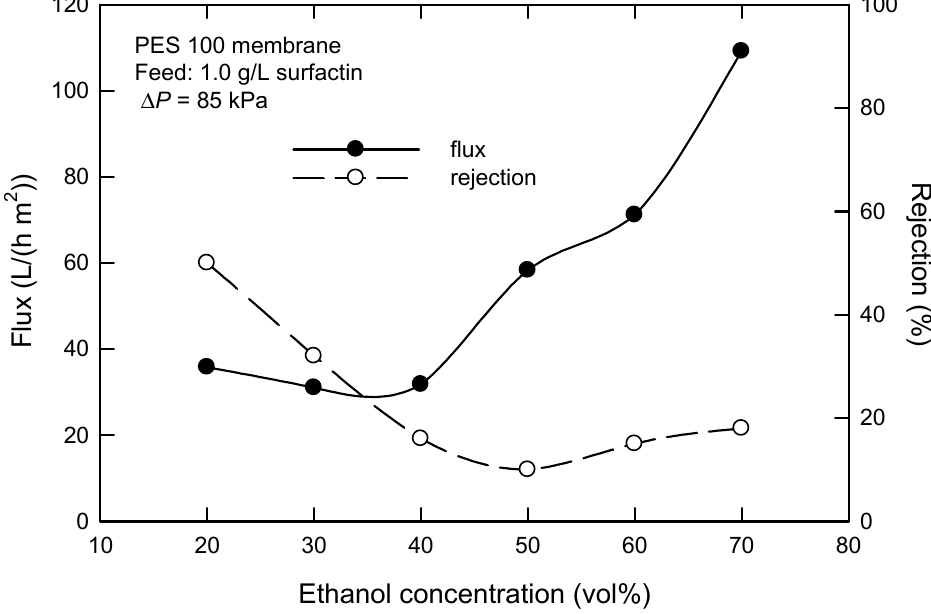
Figure 4. Effect of ethanol concentration on the flux and surfactin rejection in dead-end UF using PES 100 membrane.